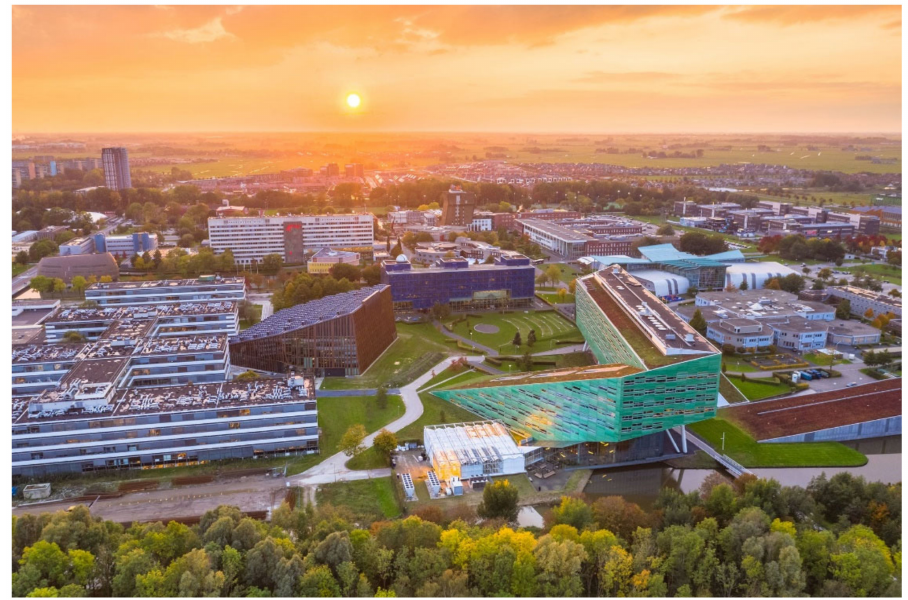
Figure 3. Zernike campus